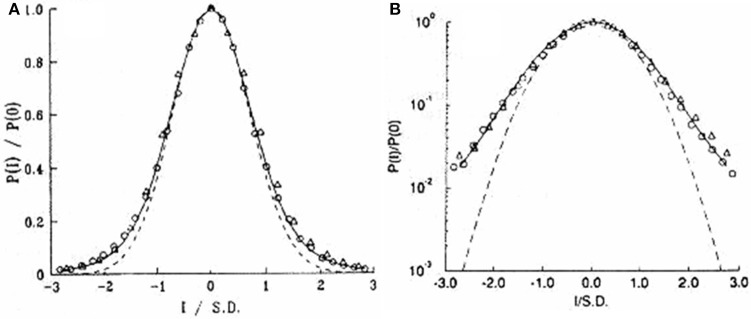
The HRV increment data is fit with a Lévy distribution (solid curve) and compared with a Gauss distribution (dashed curve). Healthy (circles) and diseased (triangles) individuals are depicted with the data normalized to the standard deviation and the probabiltiy density to P(0). The same data are plotted in (A,B) only the vertical axis has been changed to a logarithm in the latter to emphasize the separation between the Gauss and empirical distributions (Adpated from Peng et al., 1993).